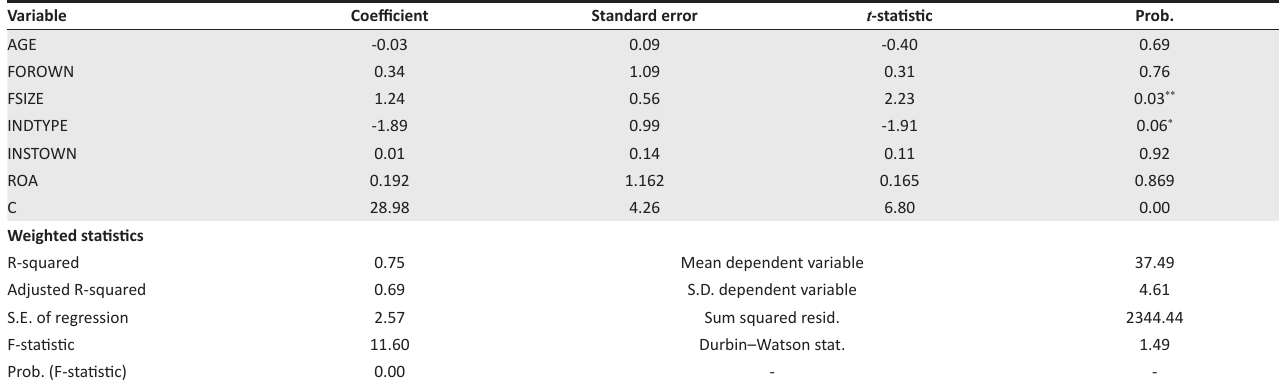
TABLE 6 : Random effect result.